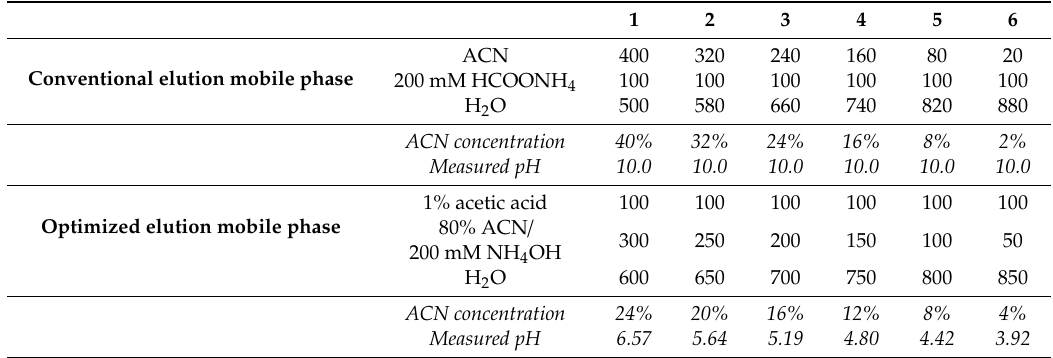
Table 1. Comparison of the composition of the conventional high-pH-RP and our optimized pH / acetonitrile (ACN)-gradient-RP elution mobile phases.